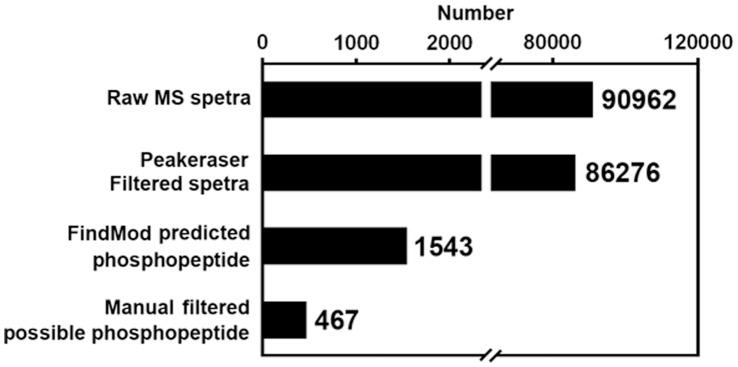
Phosphorylation site prediction of 235 differentially expressed proteins in elongating cotton fiber cells.The Peakeraser filter could partly eliminate the contamination peaks from the raw MS spectra, and further manual filter of the mistaken assignments of contaminated peptides to possible phosphopeptide largely diminished the prediction false-positive rate.